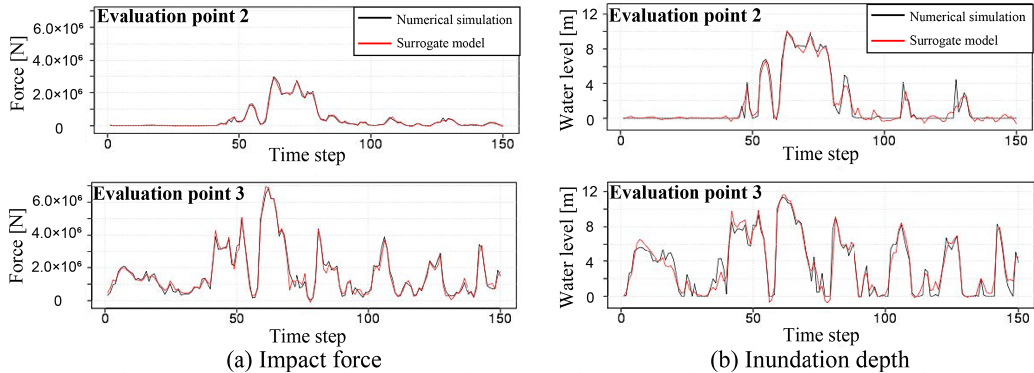
Figure 16. Comparison of time-series data obtained from numerical analysis and those reconstructed by using spatial modes.